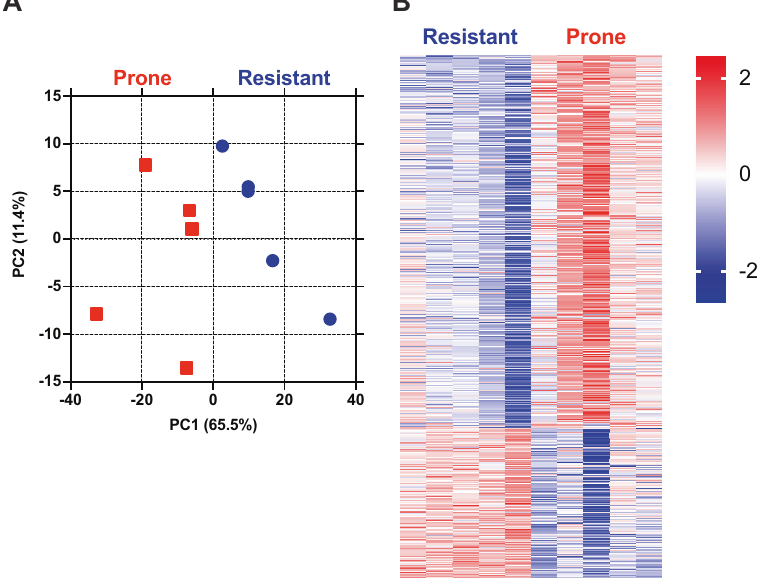
Fig. 2 RNA sequencing analysis displays differential gene expression between ‘ prone ’ and ‘ resistant ’ cohorts. A . Principal component analysis. B Heat map of differentially expressed genes between cohorts.